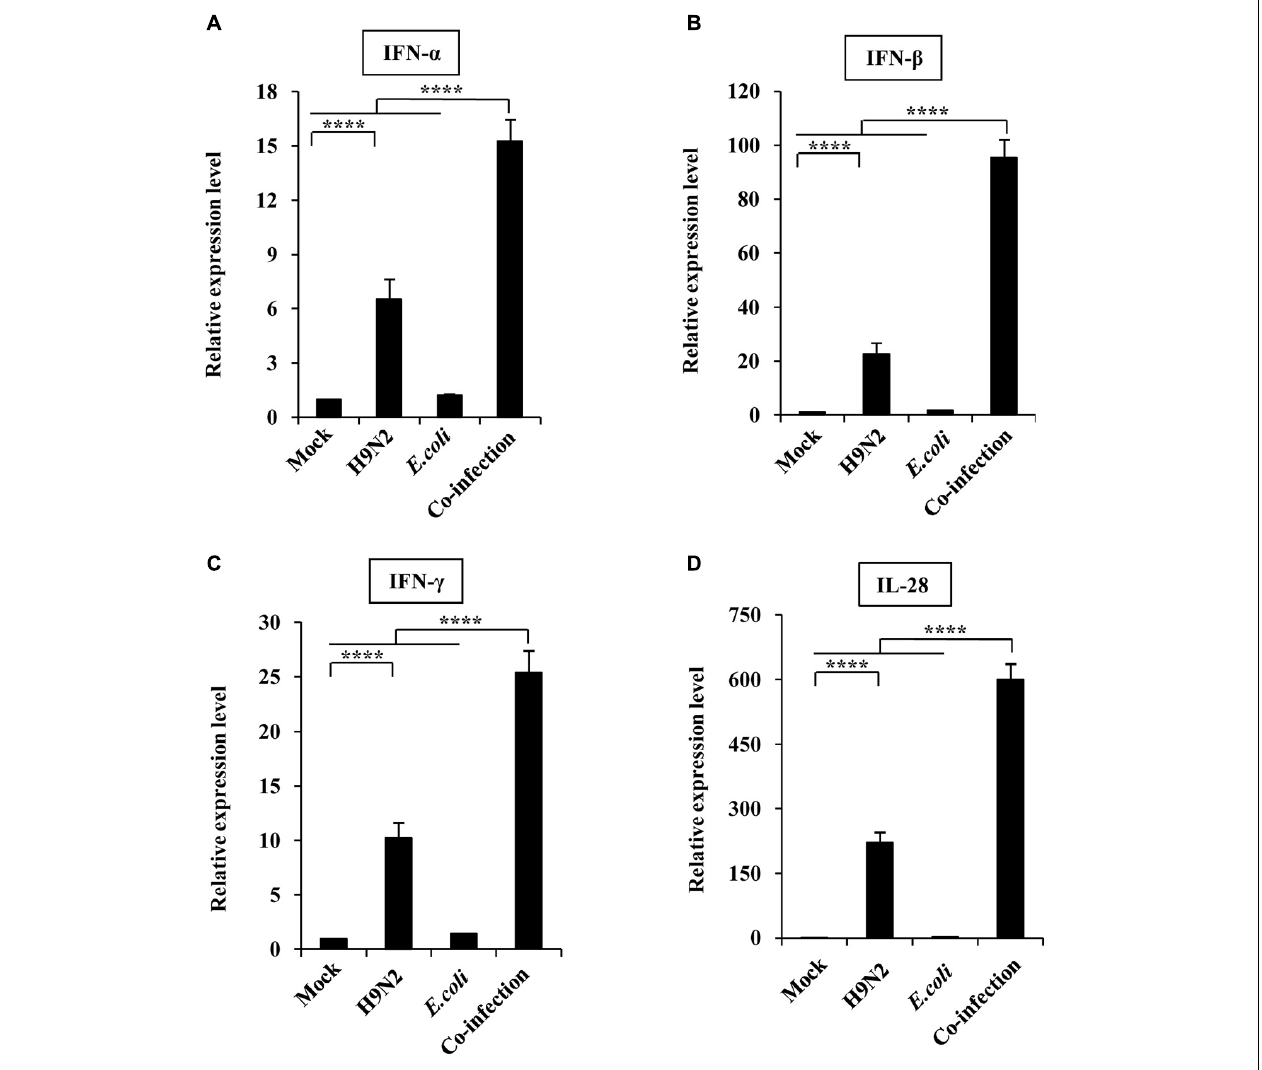
FIGURE 4 | Viral-bacterial co-infection induces aberrant expression of interferons. Four groups of BALB/c mice were mock infected, or intranasally infected with single H9N2 AIV (1 × 10 4 PFU) and E. coli (1.5 × 10 7 CFU), or co-infected with H9N2 and E. coli for 48 h. Quantitative real-time PCR was used to measure the expression of IFN α (A) , IFN β (B) , IFN γ (C) , and IL-28 (D) in mouse lungs. Data are presented as the mean ± SD of three independent experiments. **** P <